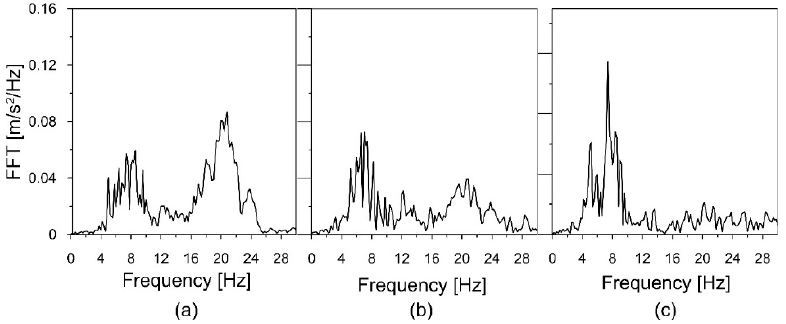
Figure 4. The frequency spectra of the acceleration up to 30 Hz registered in the LGCD region: ( a ) horizontal direction WE; ( b ) horizontal direction NS; ( c ) vertical direction Z.